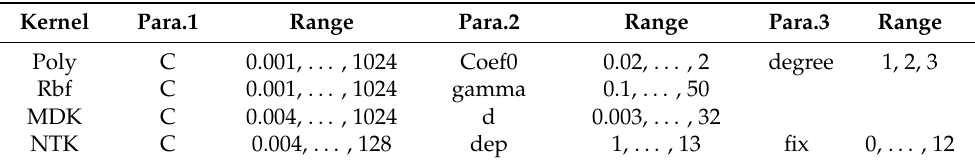
Table 1. Support vector model parameter settings. Kernel Para.1 Range Para.2